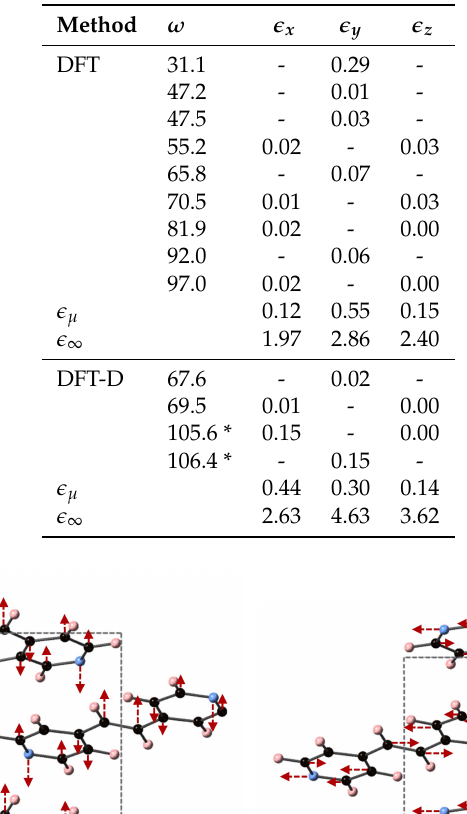
Table 3. Mode-by-mode analysis of the directional components of the IR active response of BPE for DFT (top) and DFT-D (bottom) for the THz frequency range of 20–110 cm − 1 . ω are given in units of cm − 1 and all (cid:101) are unitless. Asterisks (*) are next to the frequencies with high contributions to (cid:101) µ , and are shown in Figure 3. The two final rows in each of the DFT and DFT-D calculations are the total ionic portion of the dielectric response per direction x , y , z per mode µ (denoted as (cid:101) µ ), and the directionally decomposed electronic contribution of the dielectric response (cid:101) ∞ .